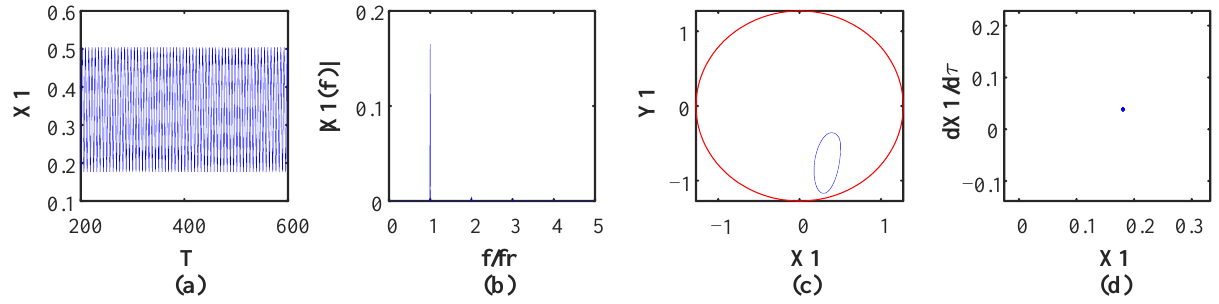
Figure 7. Numerical integration results at ω = 680 rad/s: ( a ) Time domain waveform; ( b ) Frequency spectrum; ( c ) Shaft orbit; ( d ) Poincaré map.